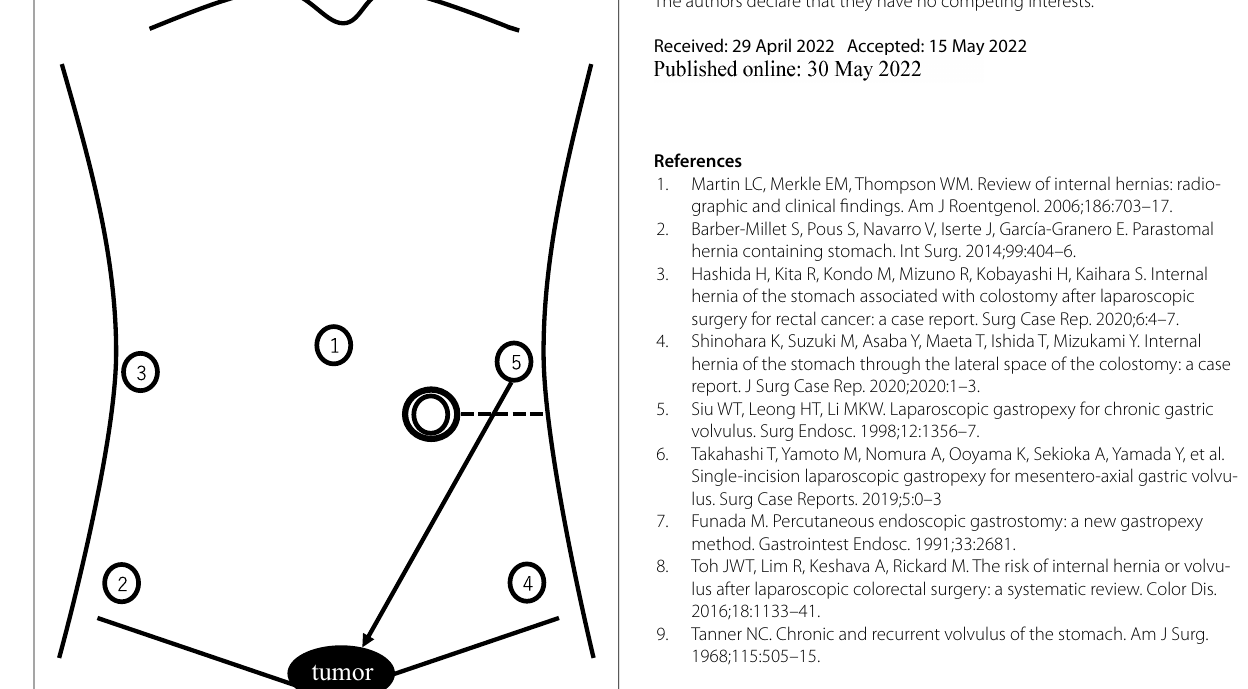
Abbreviation CT: Computed tomography.